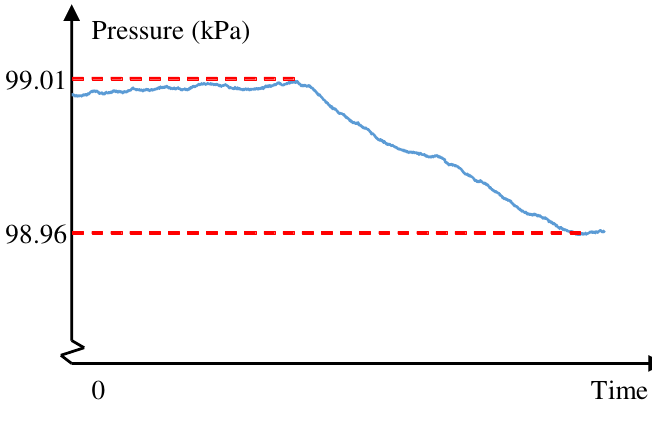
Figure 10. Pressure variations when going